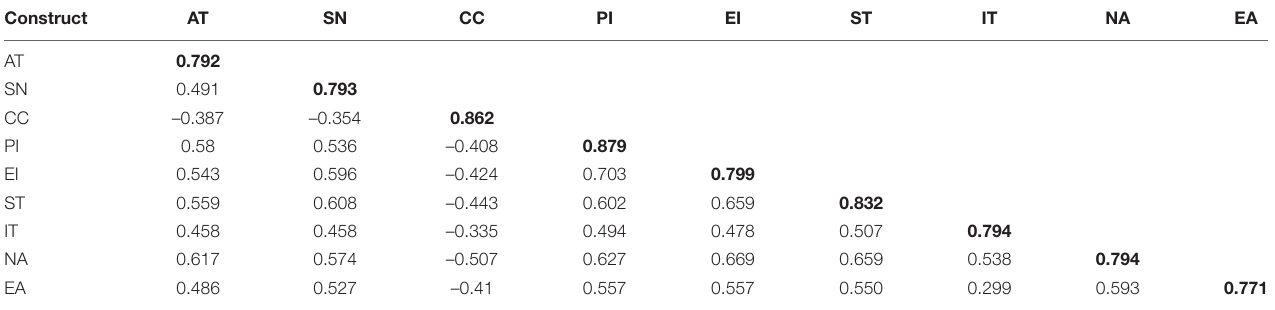
TABLE 1 | Correlations and square roots of AVEs (Fornell–Larcker criterion).